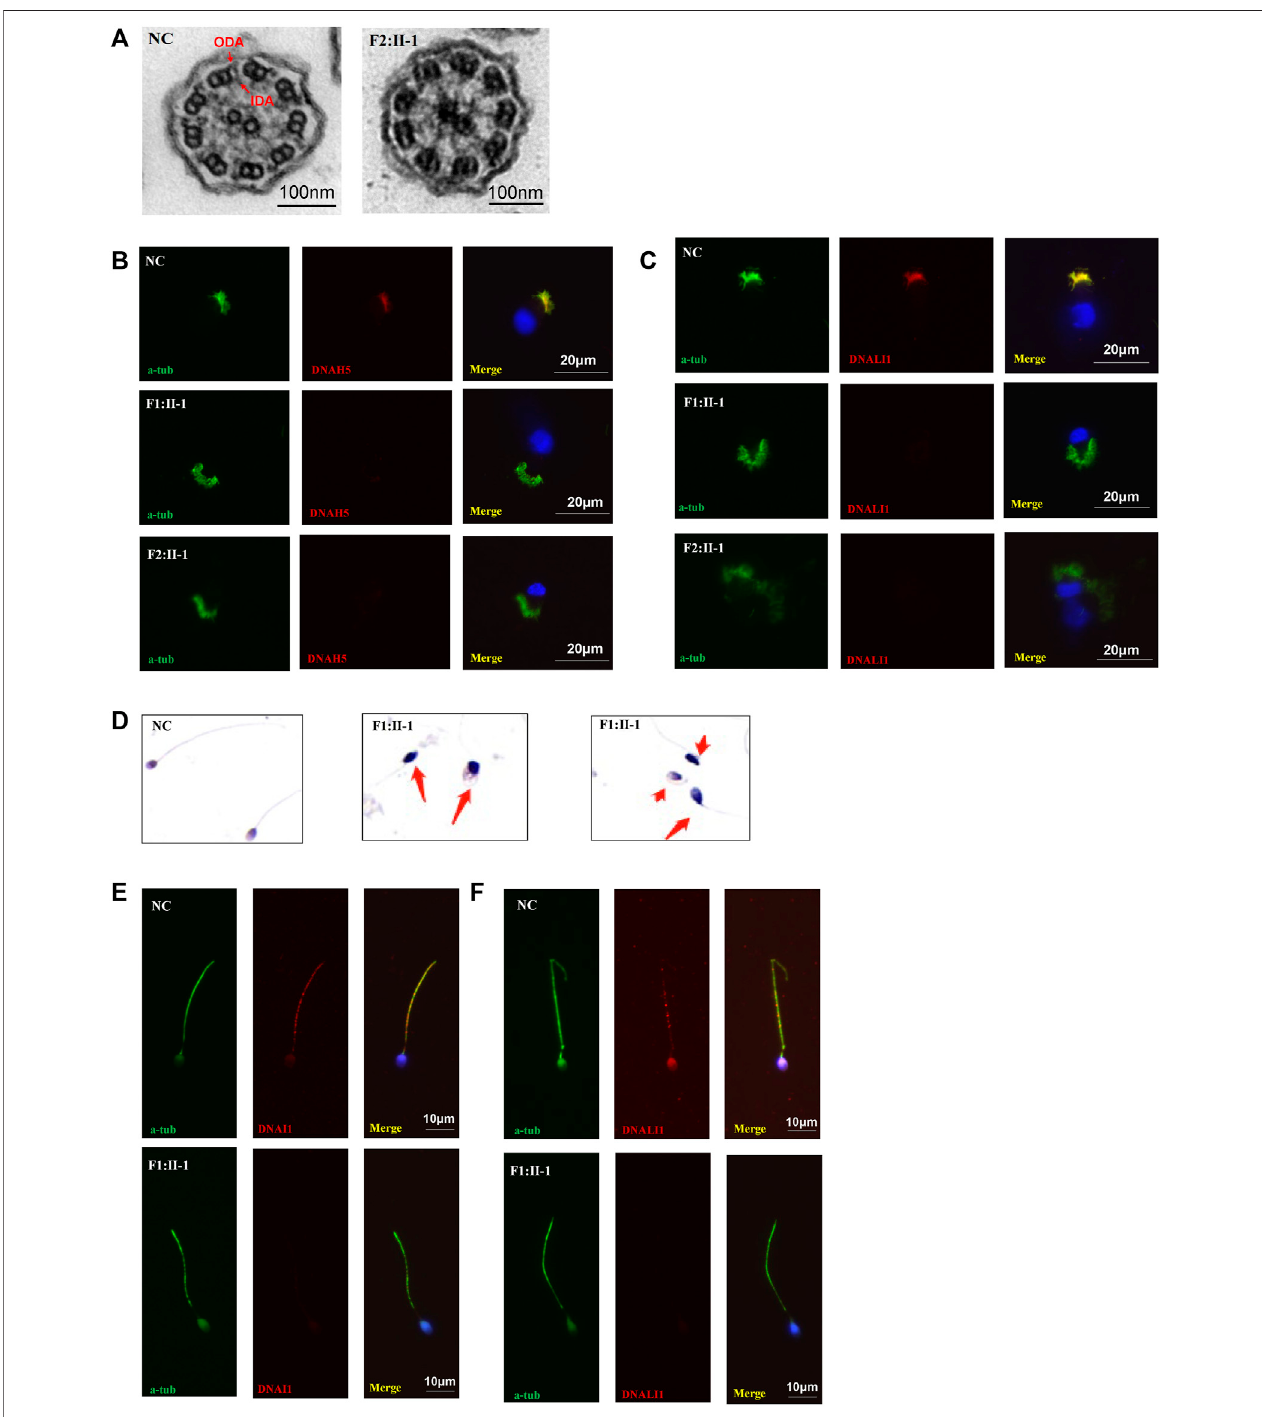
FIGURE3 | TEM, HE staining, and immuno fl uorescence analysisof thenasal ciliated cells and sperm. (A) TEManalysisindicatedloss ofIDAs and ODAs ofP2 (F1: Ⅱ -1) compared with the normal control. Scale bars, 100 nm; (B,C) immuno fl uorescence of nasal ciliated cells revealed the absence of DNAH5 and DNALI1 (red) of the two patients compared with normal control. Anti-acetylated tubulin monoclonal antibody was used to mark the ciliary axoneme. DNAH5 was used to label the outer dynein arm (ODA), DNALI1 was used to label the inner dynein arm (IDA), and DAPI was used to label the nuclei. Scale bars, 20 μ m; (D) HE staining of sperm. Comparedtonormalcontrols,the patient ’ ssperm had signi fi cantshort,coiled, and irregulartails. (E) immuno fl uorescenceanalysisshowed theabsence ofDNALI1 and DNAI1 (red) in the mutant sperm from P1 (F1: II-1) compared with the normal control. Scale bars, 10 μ m.